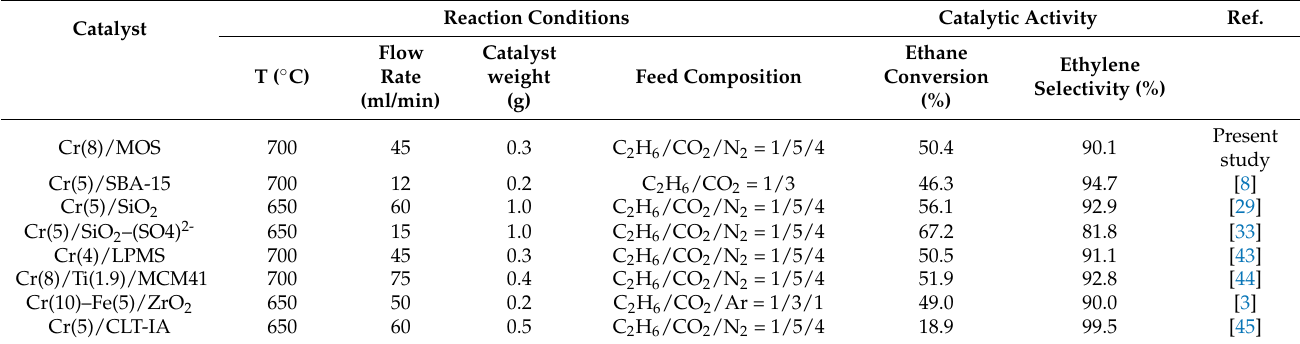
Figure 7. For all samples, the conversion of ethane and the yield of ethylene decreased slowly over catalytic time, proposing a slight de ‐ activation of the tested catalysts. Unlike our previously [3,12,46] investigated catalytic systems, deactivation of the Cr(x)/MOS cat ‐ alytic system declined approximately 22% after 10 h of on ‐ stream operation. For instance, using large ‐ pore mesoporous silica as a support for the chromium ‐ based catalytic system led to the same catalytic activity (50.5% and 91.1% conversion of ethane and selectivity of ethylene, respectively), but with 39% declination in the catalytic activity for the same re ‐ action conditions [43]. Additionally, the results of this work are comparable to those other researcher groups, indicating its importance. Shi et al., for example, tested Cr(5) /SBA ‐ 15 for ethane dehydrogenation and found that the ethane conversation dropped from 46.3 to 23.6% after reacting for 5 h [8]. In addition to coke formation, the catalyst deactivation took place basically due to the reduction of high valence states of CrOx species, whereas the numbers of re ‐ oxidized Cr 3+ species were reduced with the passage of reaction time while the non ‐ redox agglomerated Cr sites were increased. However, enhancement of the stability of Cr(x)/MOS catalysts could partly be attributed to the presence of organic com ‐ ponents on the wall pore which may resist the agglomeration of Cr sites and inhibit cata ‐ lyst sintering.